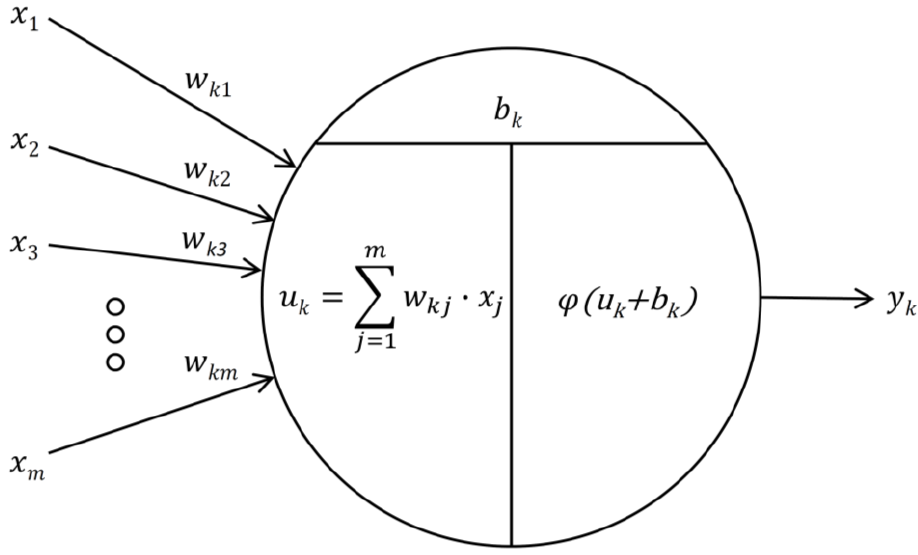
Figure 3. A nonlinear model of a neuron.